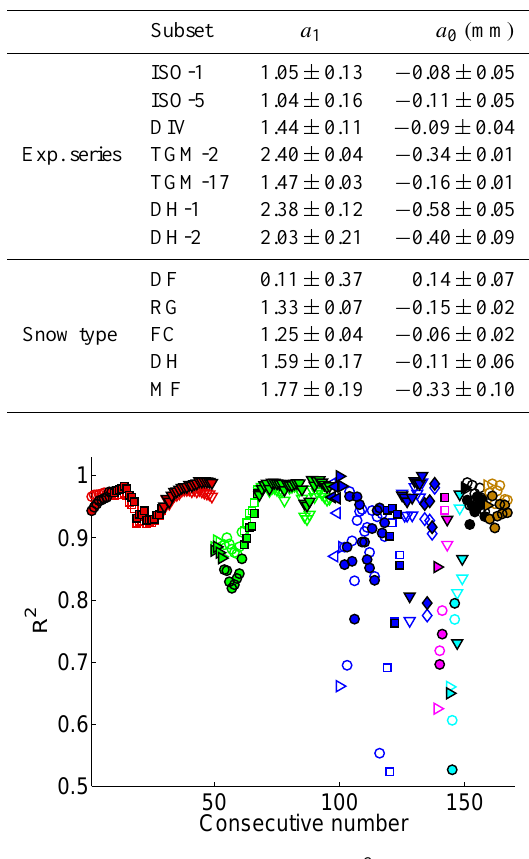
Figure 7. Coefficient of determination R 2 for the SHS model (open symbols). In addition, R 2 for the exponential model is shown (filled symbols). Experiment series are indicated by colors (TGM- 17: red, TGM-2: green, DIV: blue, DH-1: magenta, DH-2: cyan, ISO-1: black, ISO-5: brown) and snow types by markers (PP: (cid:67) , DF: (cid:66) , RG: ◦ , FC: (cid:3) , DH: ∨ , MF: (cid:5) ).